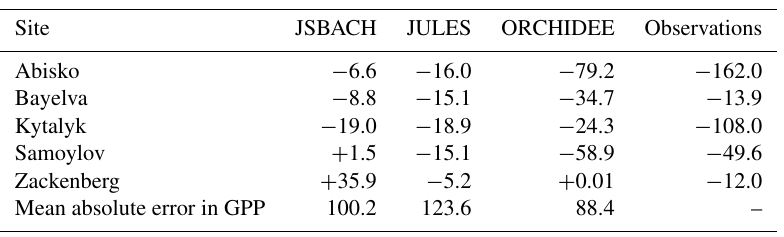
Table 3. Mean NEE budget (g Cm − 2 yr − 1 ), showing that in general this is smaller than the errors in simulated GPP; therefore, the noise is larger than the signal in this data. Positive numbers represent a carbon source.